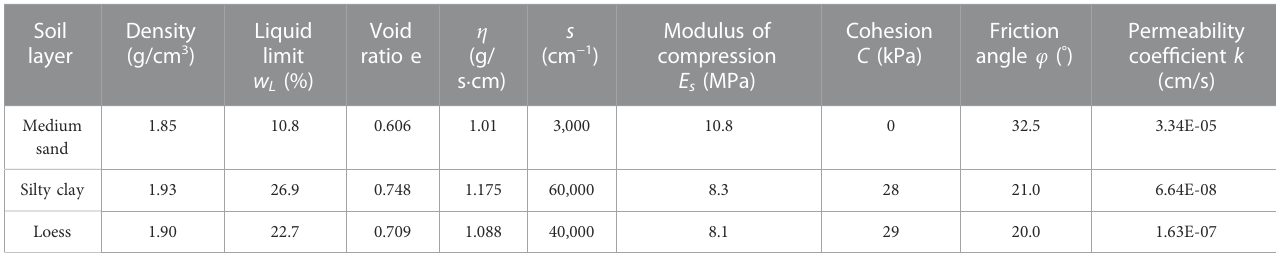
TABLE 3 Parameter value of soil for dewatering and consolidation